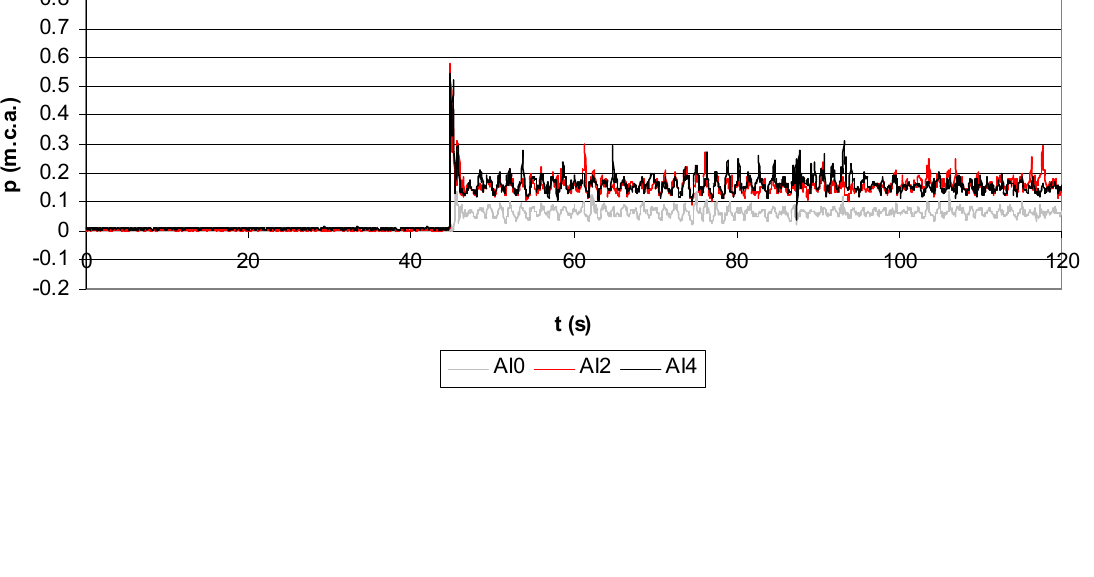
Figure 5. Typical pressure trend detected by the pressure probe vs .